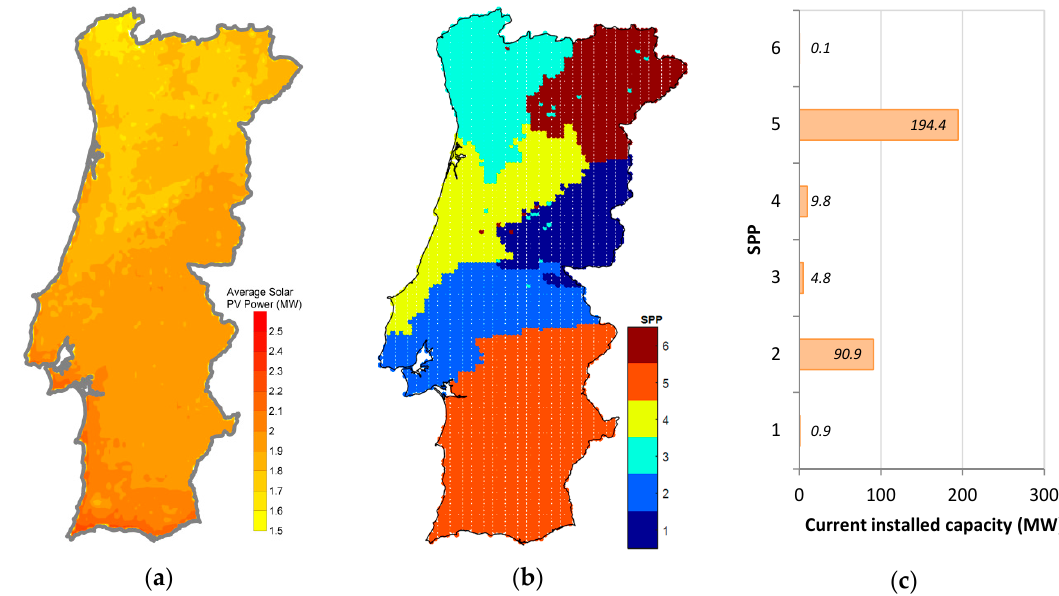
Figure 6. ( a ) Average solar PV power]; ( b ) spatial distribution of each solar power profiles (SPP) and ( c ) the current solar PV power capacity in each SPP.